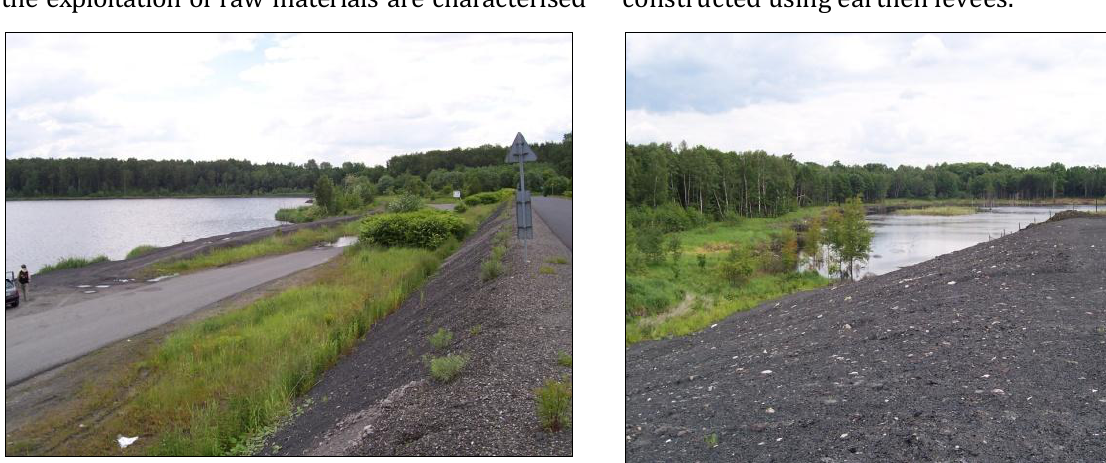
Fig. 7. “Knurów V” water reservoir near the mining spoil heap ( E. Jaruchiewicz